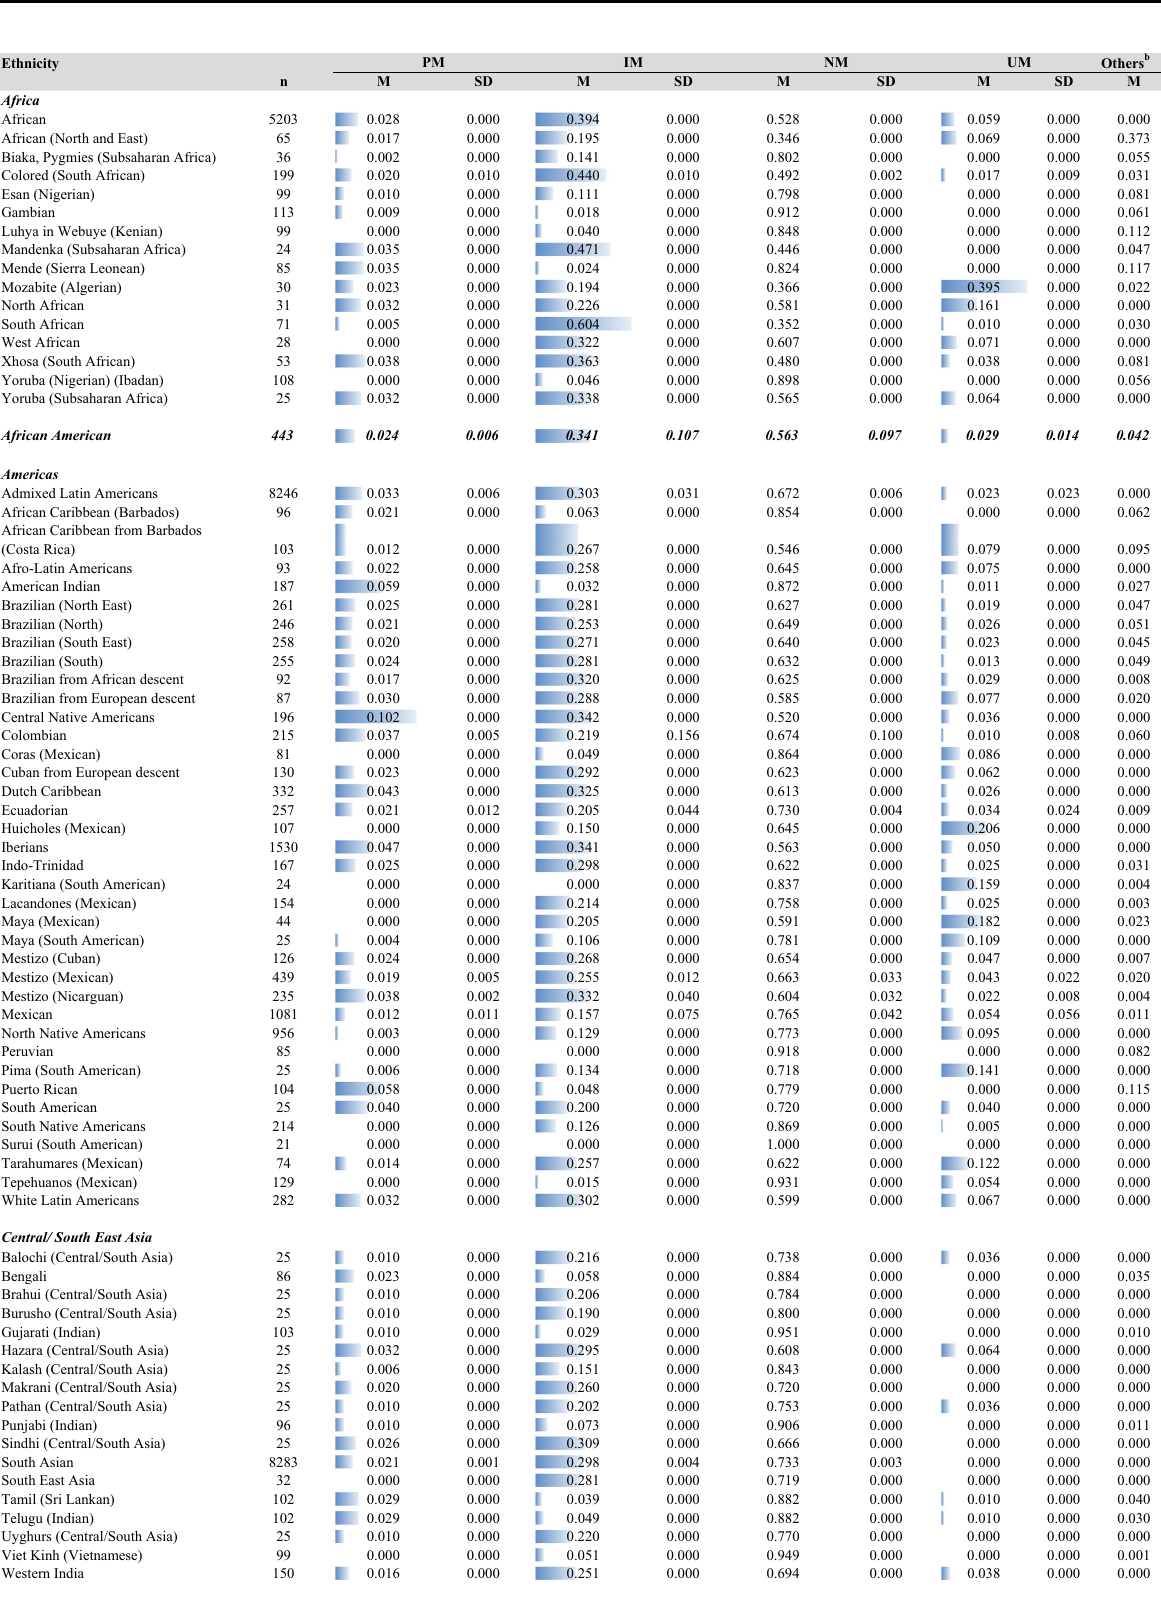
Table 3 Mean frequencies of CYP2D6 predicted phenotypes per ethnicity a .